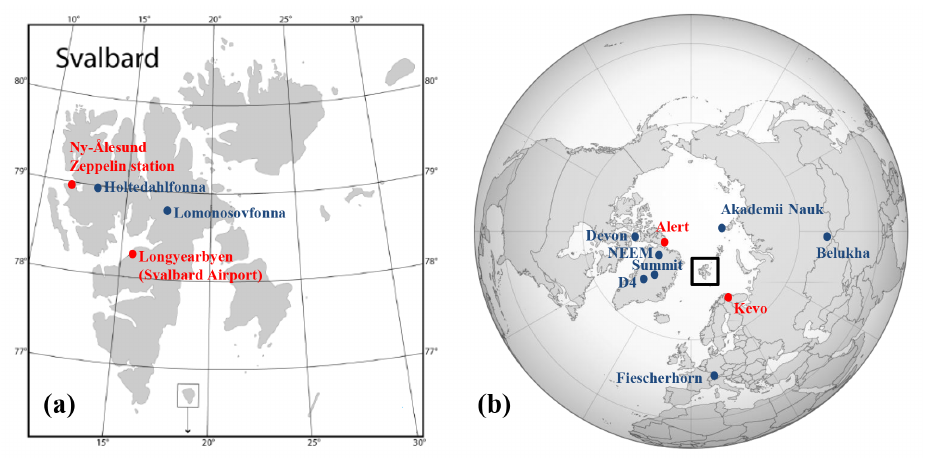
Figure 1. (a) Map of Svalbard with the location of the sites of interest (adapted from Wendl et al., 2015). (b) Map with the other sites of interest mentioned in this study. Ice core sites are in blue and atmospheric measurement stations in